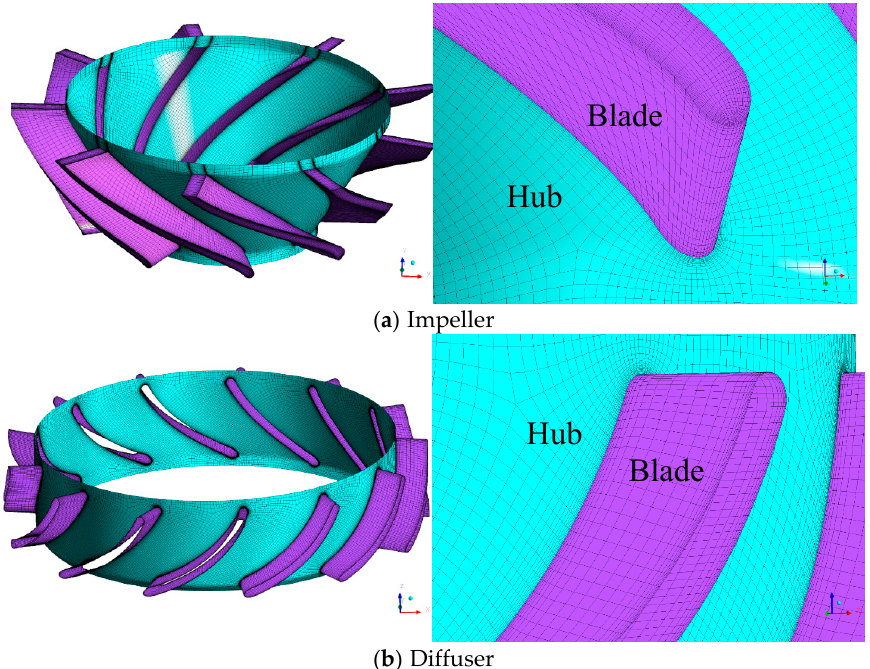
Figure 2. Computational domain and mesh. ( a ) Impeller; ( b ) Diffuser.